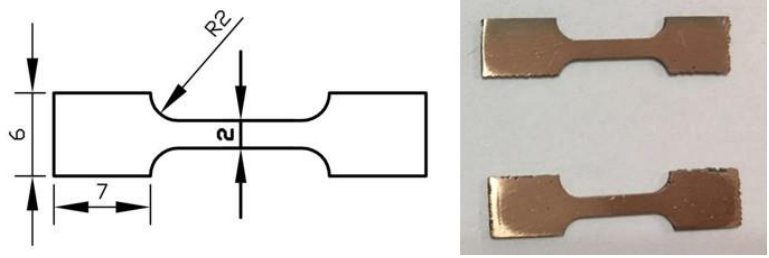
Figure 4. Tensile sample shape and size.